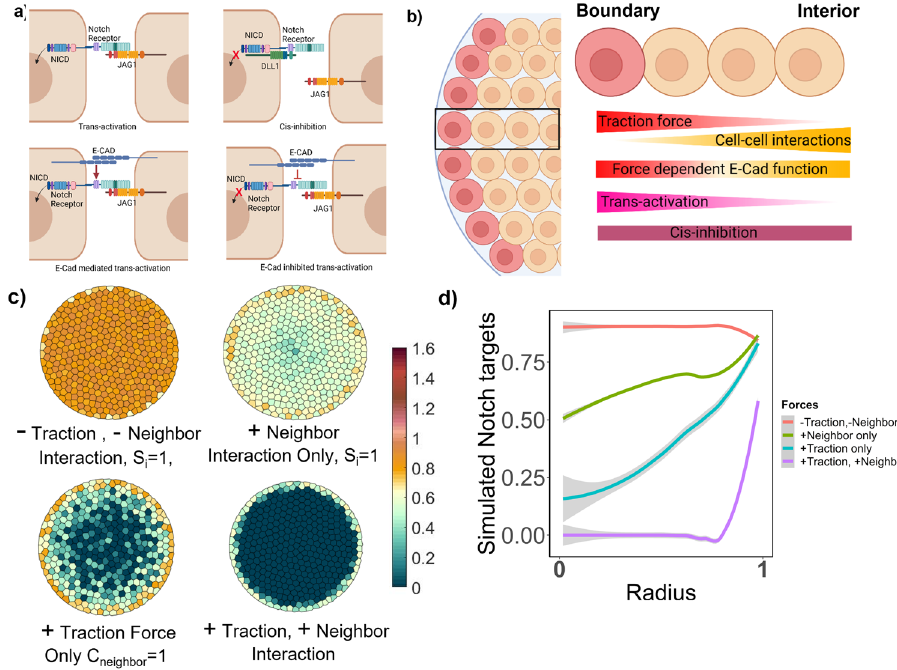
Fig. 2 Computational modeling design for simulated Notch target genes in cells on circular geometry. a Schematic of various Notch receptor – ligand interactions: trans-activation and cis-inhibition. Additionally, the bottom half of the schematic represents how E-Cadherin interacts with notch signaling. b Schematic of incorporation of the different Notch receptor – ligand interactions in cells on the boundary versus the interior. Made using biorender.com. c Simulated Notch target genes in cells on a circular lattice, with cellular forces gradients being added step by step. Heatmap color: arbitrary unit for Notch target genes. d Quanti fi cation of simulated Notch target genes in cells on a circular lattice for the different models in c . Gray: 95% con fi dence interval.